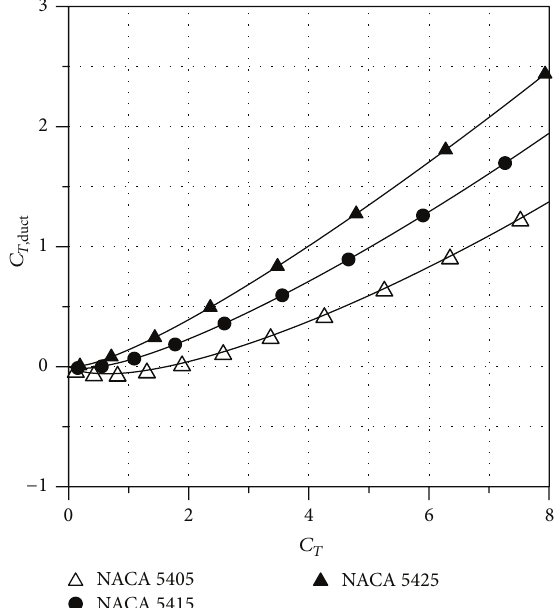
Figure 4: Effects of the profile thickness on the duct thrust